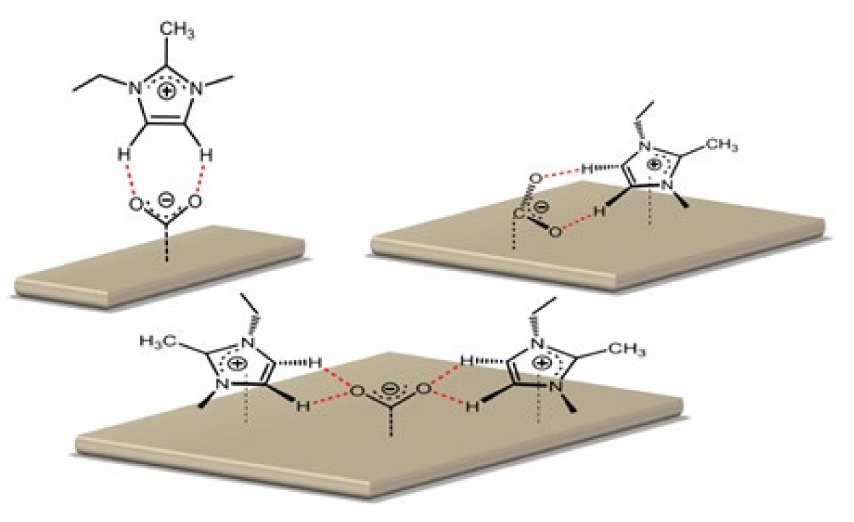
Figure 11. The interaction between the active imidazolium protons and CO 2 . Reprinted with permission from [87]. Copyright 2014, American Chemical